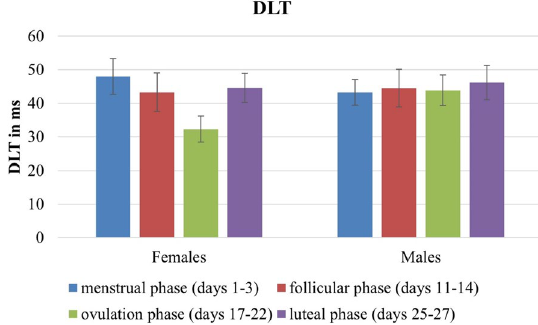
Fig. 3 The mean and standard deviation of scores obtained for DLT in males and